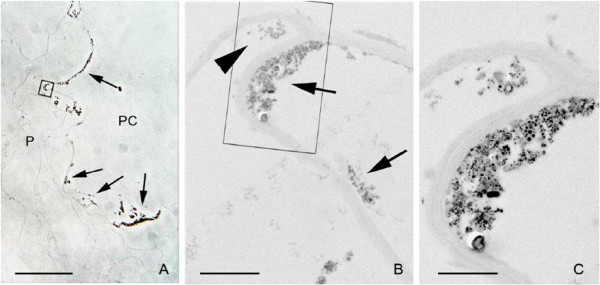
Penetration of nanoparticles into the first cell layer surrounding the pith cavity. (A) Phase contrast image of the parenchymatic cells (P) closer to the pith cavity (PC). The nanoparticle aggregates on the application surface appear as an optically dense material (arrows). (B) Transmission electron micrograph of the region squared in (A). Nanoparticle aggregates appear in the cell wall facing the pith cavity (arrows) and into the cytoplasm of the first cell layer (arrow head). (C) High magnification of the region squared in (B). The intracellular aggregate is smaller than the extracellular one in the pith cavity. Bar in (A) = 40 μm, (B) = 2 μm, (C) = 1 μm [105].